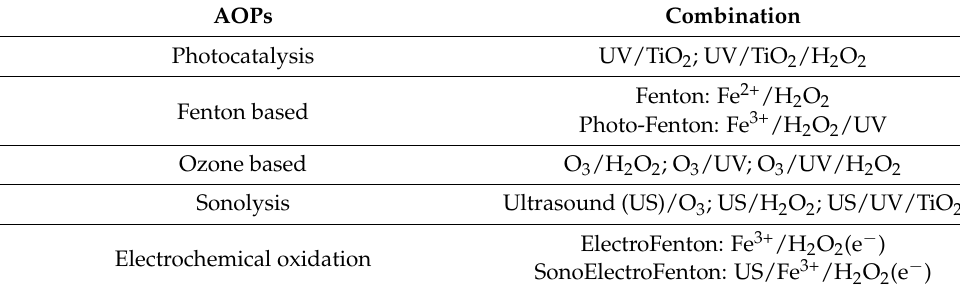
Table 4. Combination of advanced oxidation processes (AOPs)